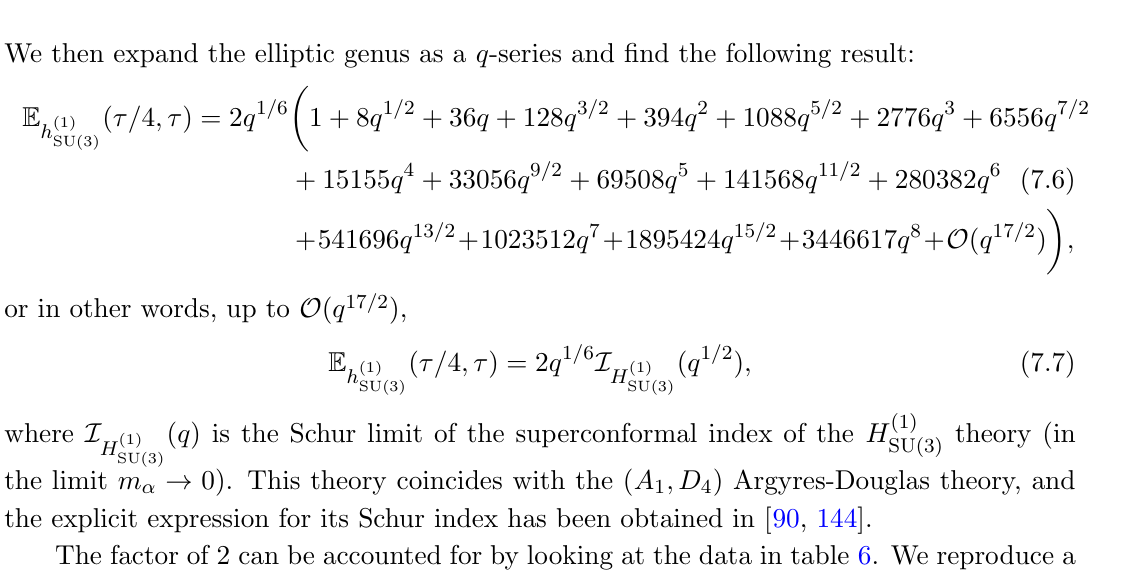
for one SU(3) k;l